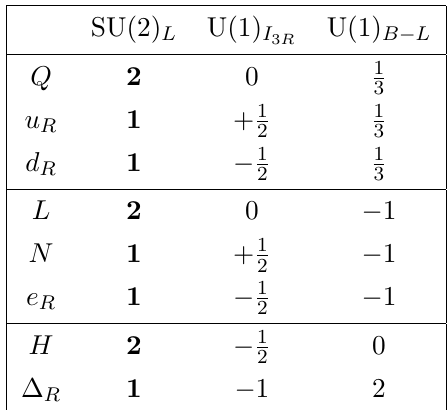
Table 1 . Particle content of the SU(2) L (cid:2) U(1) I